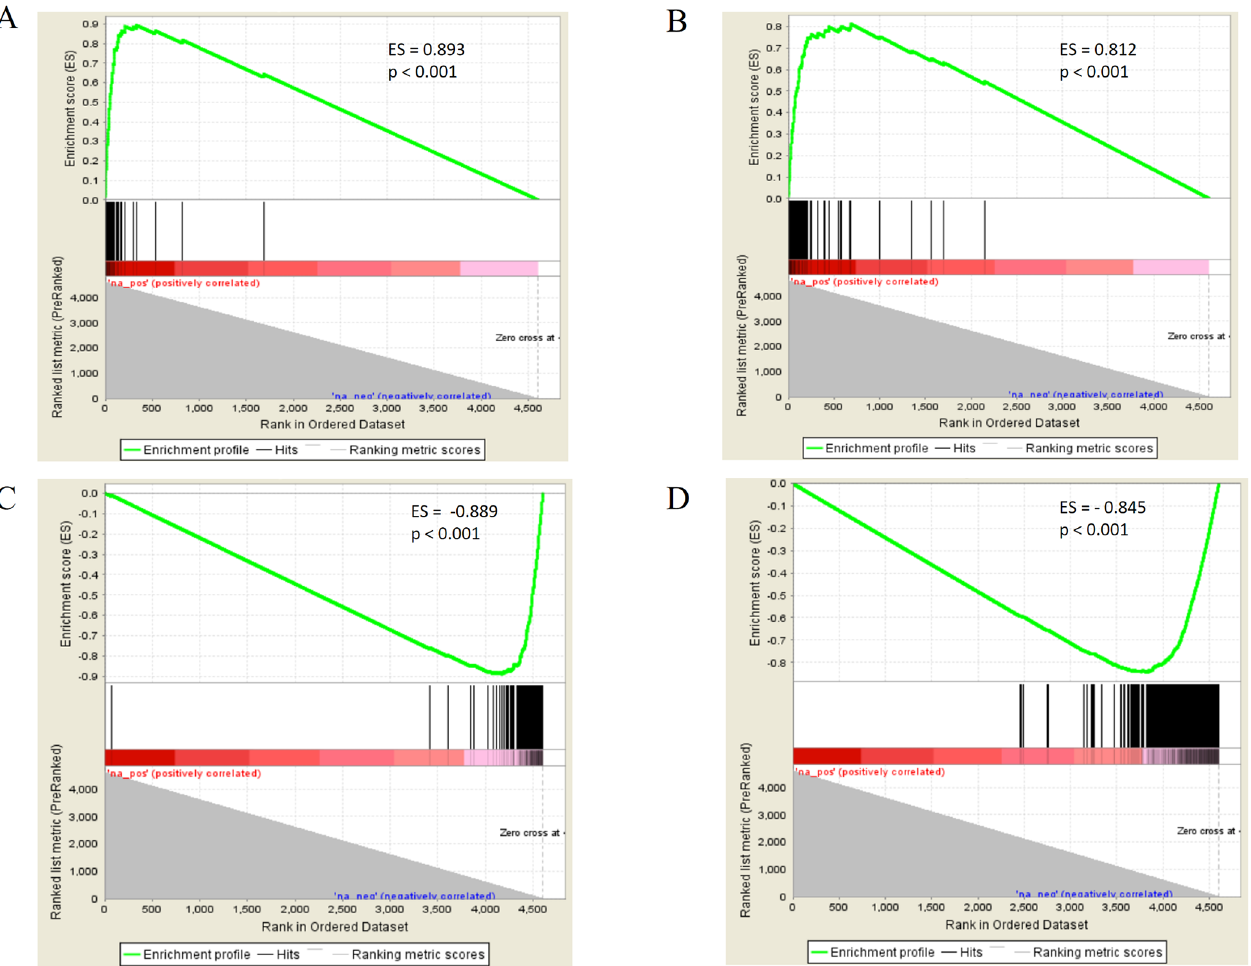
Fig 3. Gene set enrichment analysis (GSEA) of up-regulated genes between exon arraysand previously published 15K agilent array show high reproducibility of biological information. GSEA plots for chip to chip comparisons of unregulatedgenesfor HB3 12 hpi vs 36 hpi samples. Black lines indicatethe locationof “hits” from the rank order list of the up or down-regulated genes from the query list. Correlationvalues betweenranked orderedand query list is progressively calculatedand indicatedby the red bar (with stronger correlationsindicatedby darker hue). The “zero crosses at” dotted line indicateswhen the enrichment score decays back to zero and there are no more potential matches betweenthe query and rank ordered lists. (A and C) Comparing the top up-regulated and down-regulated genes on the Agilent 15K array to the rank orderedlist of all geneson the Nimblegenexon array. (B and D) Comparingthe top up-regulated and down-regulatedgenes on the Agilent HD exon array to the rank ordereddifferentialexpressionof all geneson the comparably designed Nimblegenexon array. These comparisons show that the top up- regulatedgenesbetween12 hpi and 36 hpi are consistent across all 3